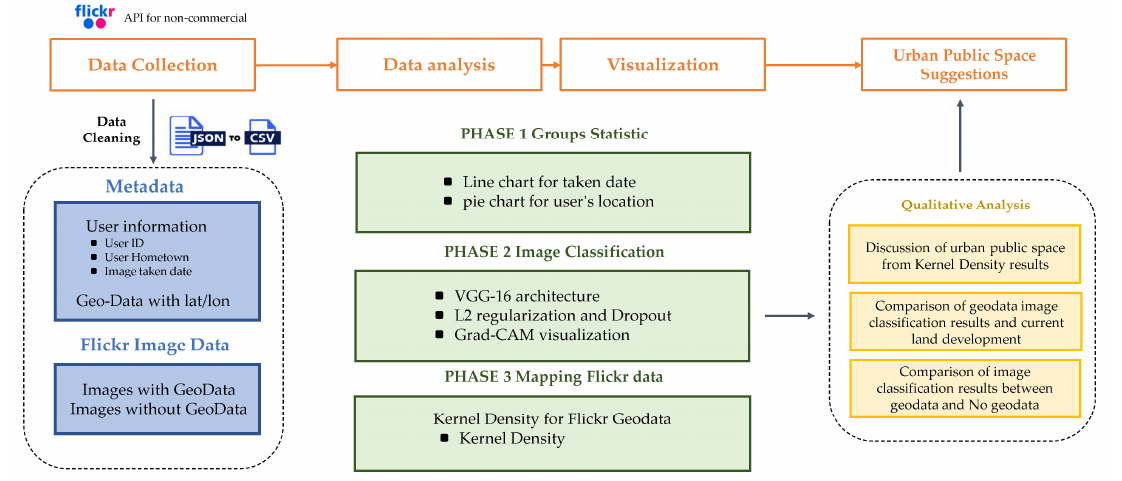
Figure 2. Flowchart of the research.